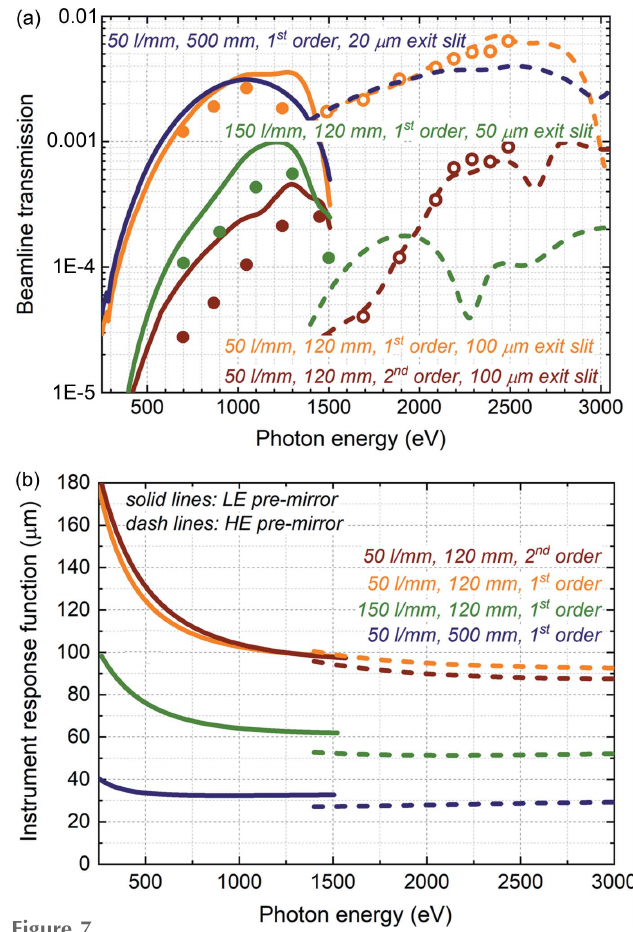
Figure 7 Transmission. ( a ) Estimated (lines) and experimentally measured (circles) beamline transmission operating with the 50 l mm (cid:2) 1 500 mm- long designed grating (20 m m exit slit), with the 50 l mm (cid:2) 1 120 mm-long installed grating (100 m m exit slit) and with the 150 l mm (cid:2) 1 120 mm-long installed grating (50 m m exit slit). Solid lines and solid circles – operation with LE premirror; dashed lines and open circles – operation with HE premirror. ( b ) Instrument response function of respective